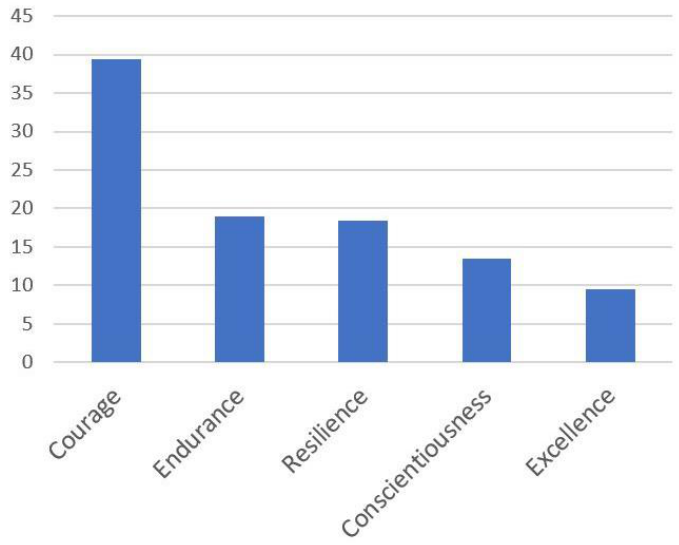
Most Recognisable Grit Characteristic